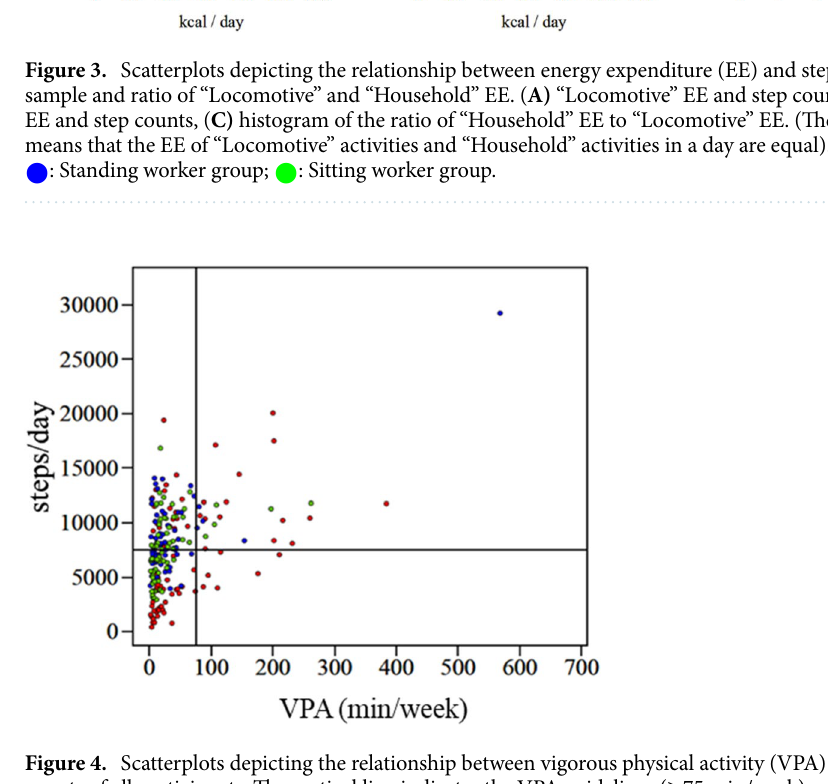
p < 0.001, respectively), and the student group had significantly shorter LPA and MPA performance times than the sitting worker group ( p < 0.001 and p = 0.036, respectively). The sitting worker group had a significantly longer SB performance time ( p < 0.001) and significantly shorter LPA, MPA, and MVPA performance times than the standing worker group ( p = 0.003, p = 0.001, and p = 0.004, respectively). However, regarding VPA, the perfor- mance time in the student group was significantly longer than those in the standing worker group and sitting worker group ( p = 0.041 and p = 0.021, respectively) (Fig. 5B). The magnitude of the exercise (≥ 1.6 METs × hour) in locomotive activities was significantly lower in the sitting worker group than in the standing worker group ( p = 0.047). Additionally, all categories of “Household” activities (METs (≥ 1.6) × hour, METs (≥ 3.0) × hour, and EE) of the student group were significantly lower than those of the standing worker group ( p < 0.001, p < 0.001, and p < 0.001 respectively), and both categories of the magnitude of exercise of “Household” activities (METs (≥ 1.6) × hour and METs (≥ 3.0) × hour) were significantly lower in the student group than in the sitting worker group ( p < 0.001 and p = 0.036, respectively). Similarly, all categories of “Household” activities were significantly lower in the sitting worker group than in the standing worker group ( p = 0.004, p < 0.001, and p = 0.033, respec- tively) (Fig. 6A,B).